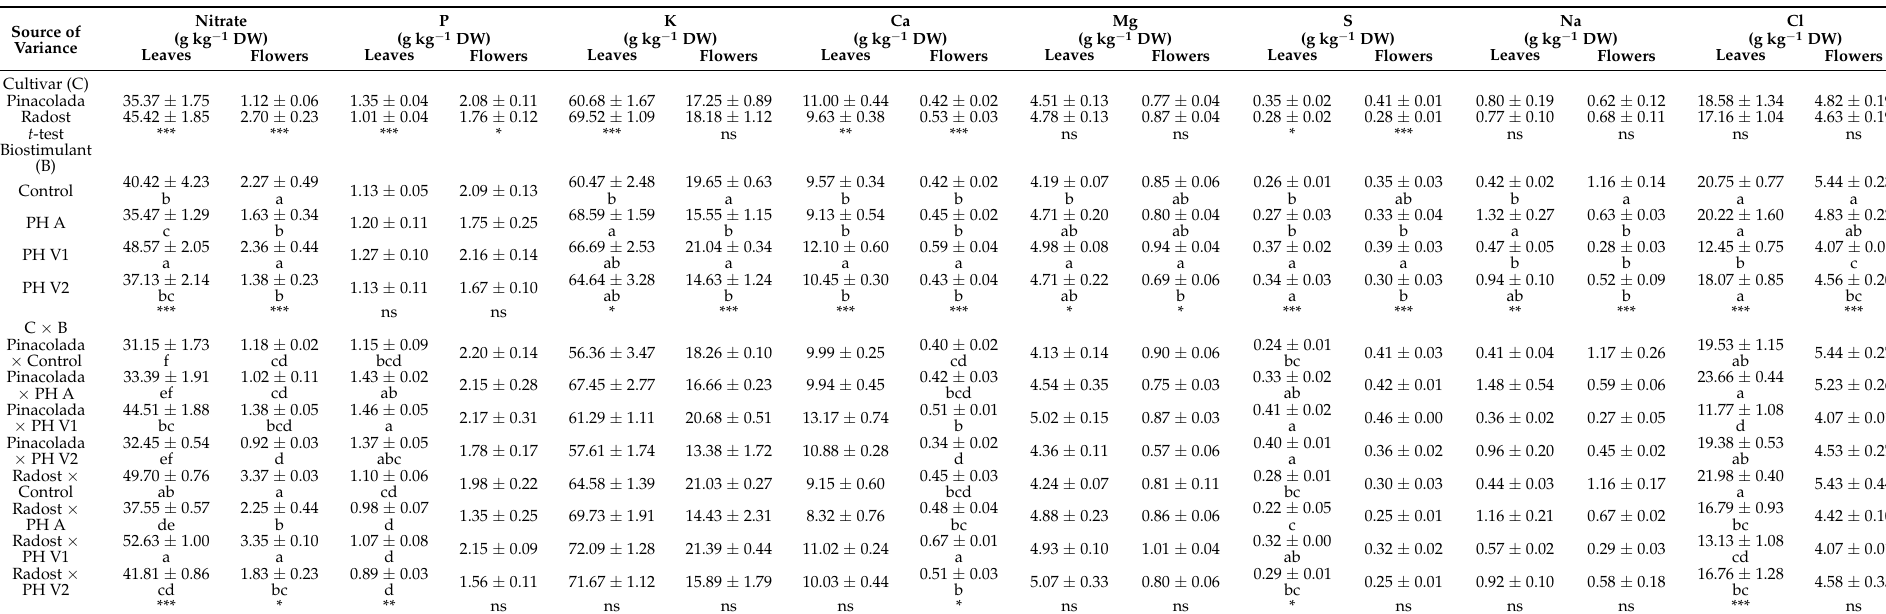
Table 4. The effect of biostimulant treatments (untreated control, one animal PH (PH A, Hicure ® ), or two vegetal PHs (PH V1; Trainer ® and PH V2; Vegamin ® )) on the mineral composition of two chrysanthemum cultivars (Pinacolada and Radost) grown under greenhouse conditions. All data are expressed as mean ± standard error; n =